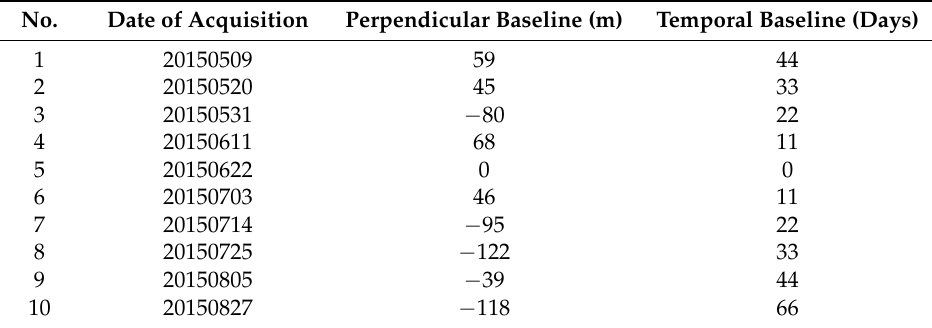
Table 1. Dates of TSX acquisition and their related